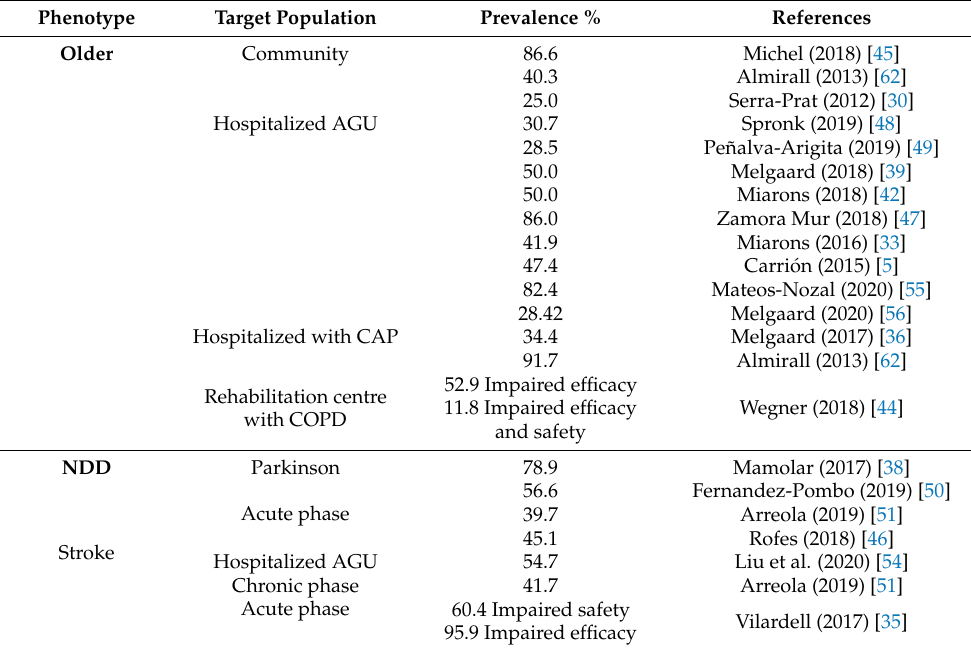
Table 5. Prevalence of oropharyngeal dysphagia (OD) in different phenotypes of patients and target populations according to the studies included in the scoping review using the volume-viscosity swallow test as a tool to clinically diagnose